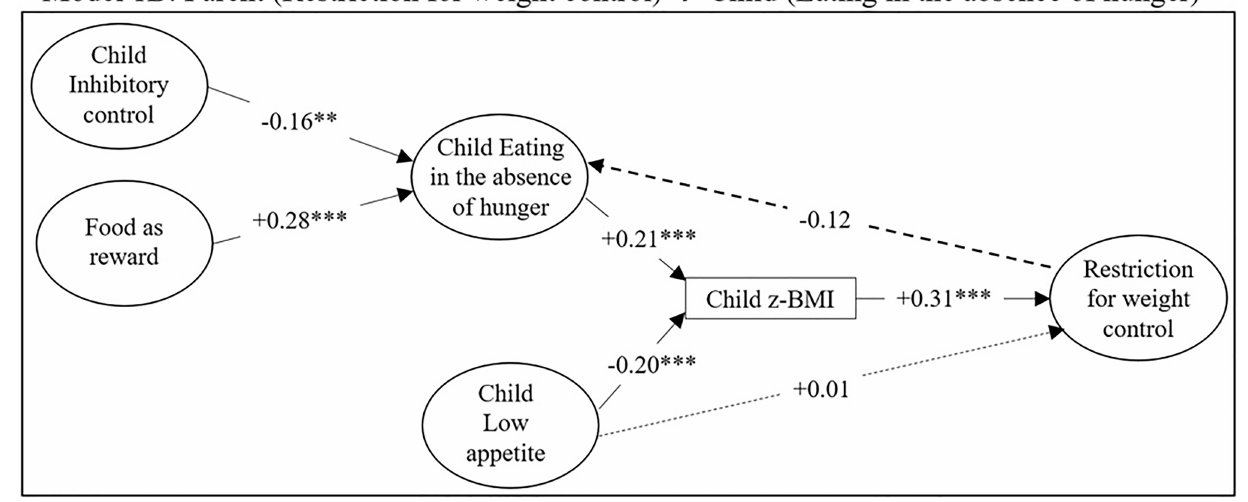
FIGURE 2 | Structural models for the associations between parental feeding practices (restriction for weight control, food as reward), child inhibitory control, child EAH, child low appetite and child body mass index (BMI) z-score. Numbers indicate standardized coefficients, solid lines indicate significant coefficients (* p < 0.05; ** p < 0.01; and *** p < 0.001), and dashed lines indicate non-significant coefficients. The correlations between the exogenous latent variables (food as reward, inhibitory control, low appetite) are not visualized here. Model 1A: model from child’s EAH to mother’s restriction for weight control. Model 1B: model from mother’s restriction for weight control to child’s